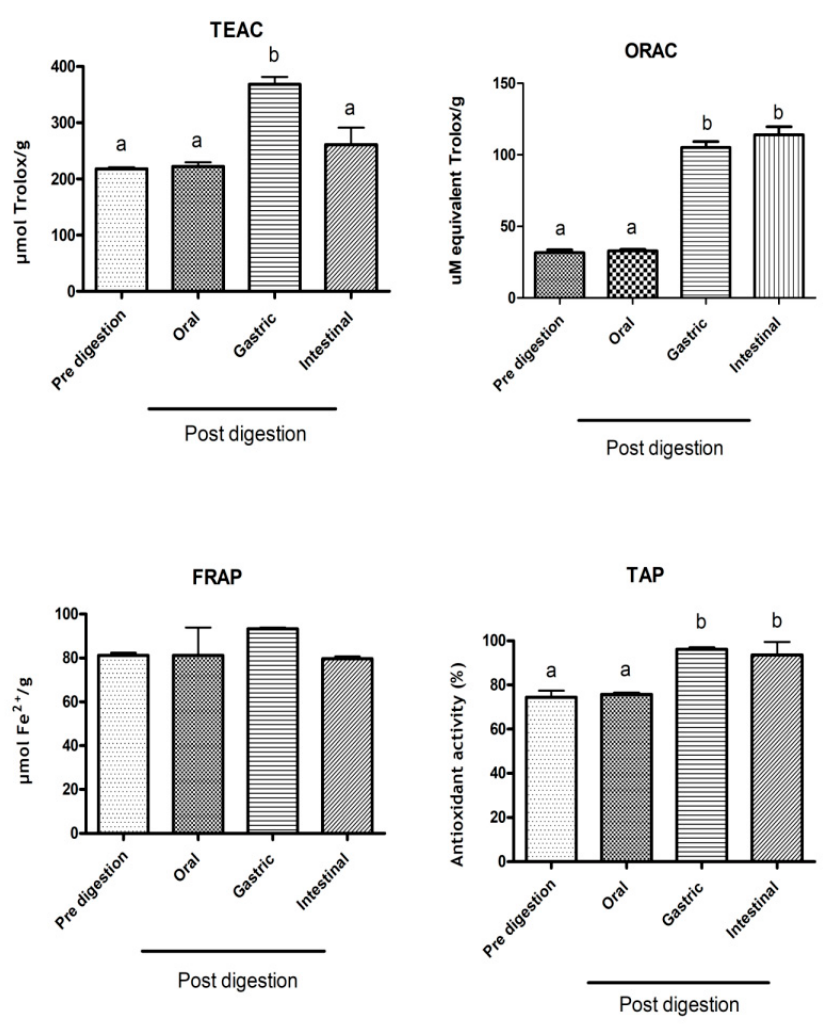
Figure 1. Antioxidant activity following in vitro simulated gastrointestinal digestion. Antioxidant capacity (TEAC), ferric reducing ability in plasma (FRAP), total antioxidant potential (TAP) and